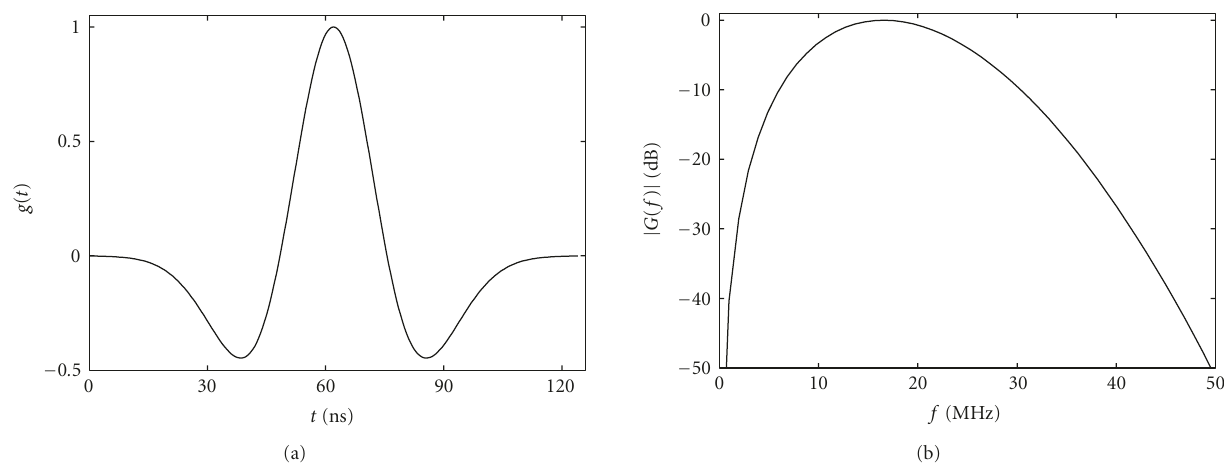
Figure 3: (a) Monocycle impulse response, g M ( t ) ∼ (1 − π (( t − D/ 2) /T 0 ) 2 )exp( − π/ 2(( t − D/ 2) /T 0 ) 2 ), where D ≈ 5 . 23 T 0 is the monocycle duration. (b) Monocycle frequency